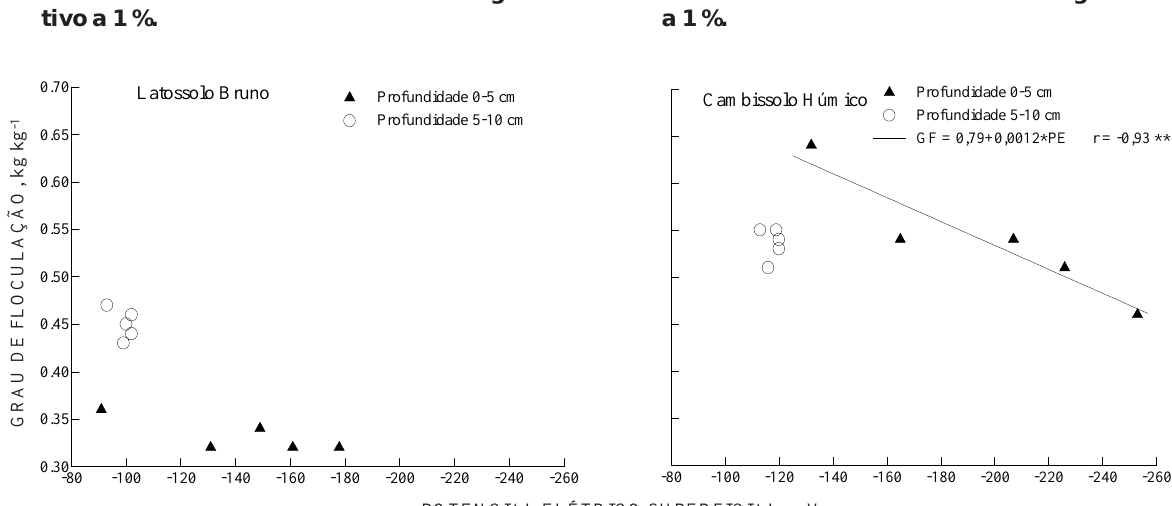
Figura 3. Relação entre as doses aplicadas de resíduo alcalino (% equivalente de CaCO potencial elétrico superficial (PE), na camada de 0-5 cm, do Latossolo Bruno distrófico e Cambissolo Húmico alumínico. ** Significativo a 1